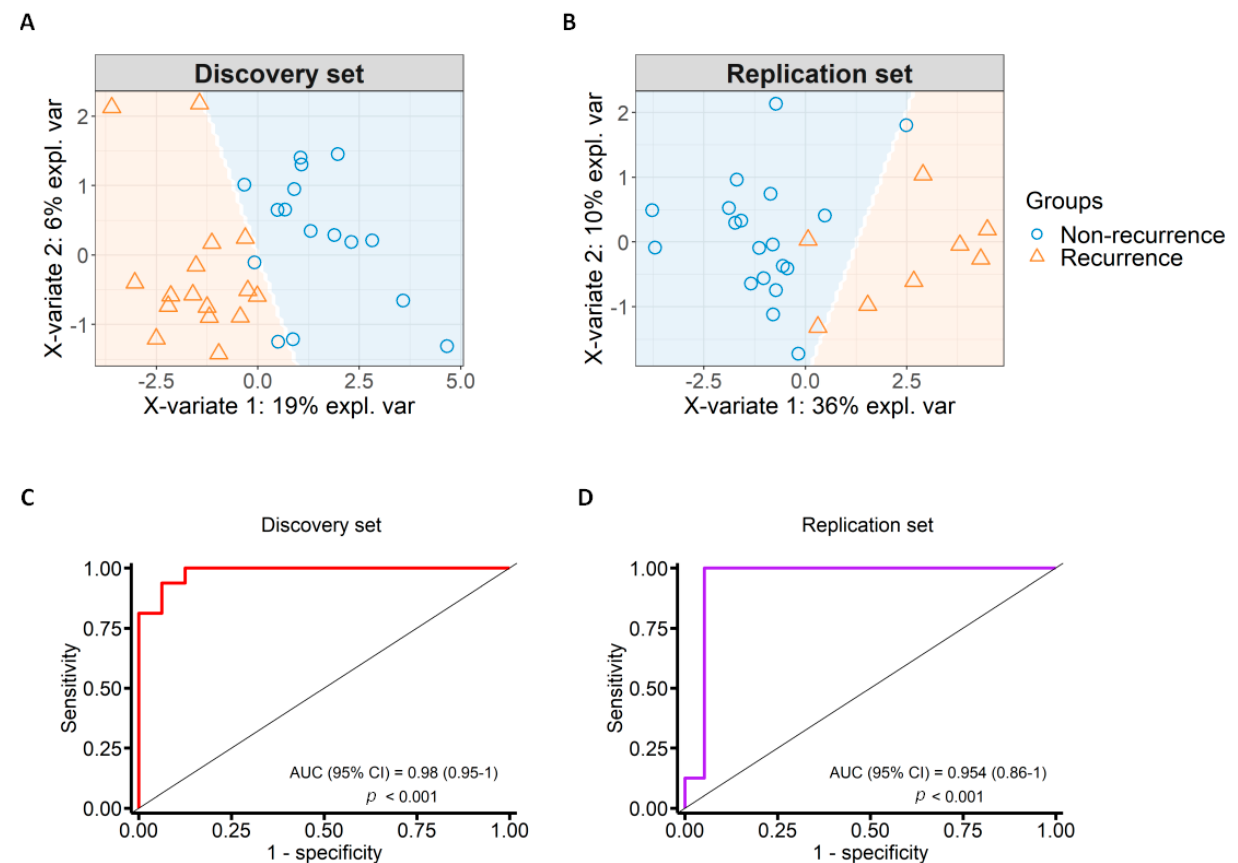
Figure 4. Marker selection with specificity and sensitivity test. ( A ) Sample prediction area from a PLS-DA model based on the 14-CpG marker panel from the discovery set; ( B ) sample prediction area from a PLS-DA model based on the 14-CpG marker panel in the replication set from TCGA; ( C ) Receiver Operating Characteristic (ROC) curve showing specificity and sensitivity of the identified DNAme markers in the discovery set. The area under the curve (AUC) was 0.98; ( D ) ROC curve showing specificity and sensitivity of the identified DNAme markers in the replication set from TCGA. The AUC was 0.95.